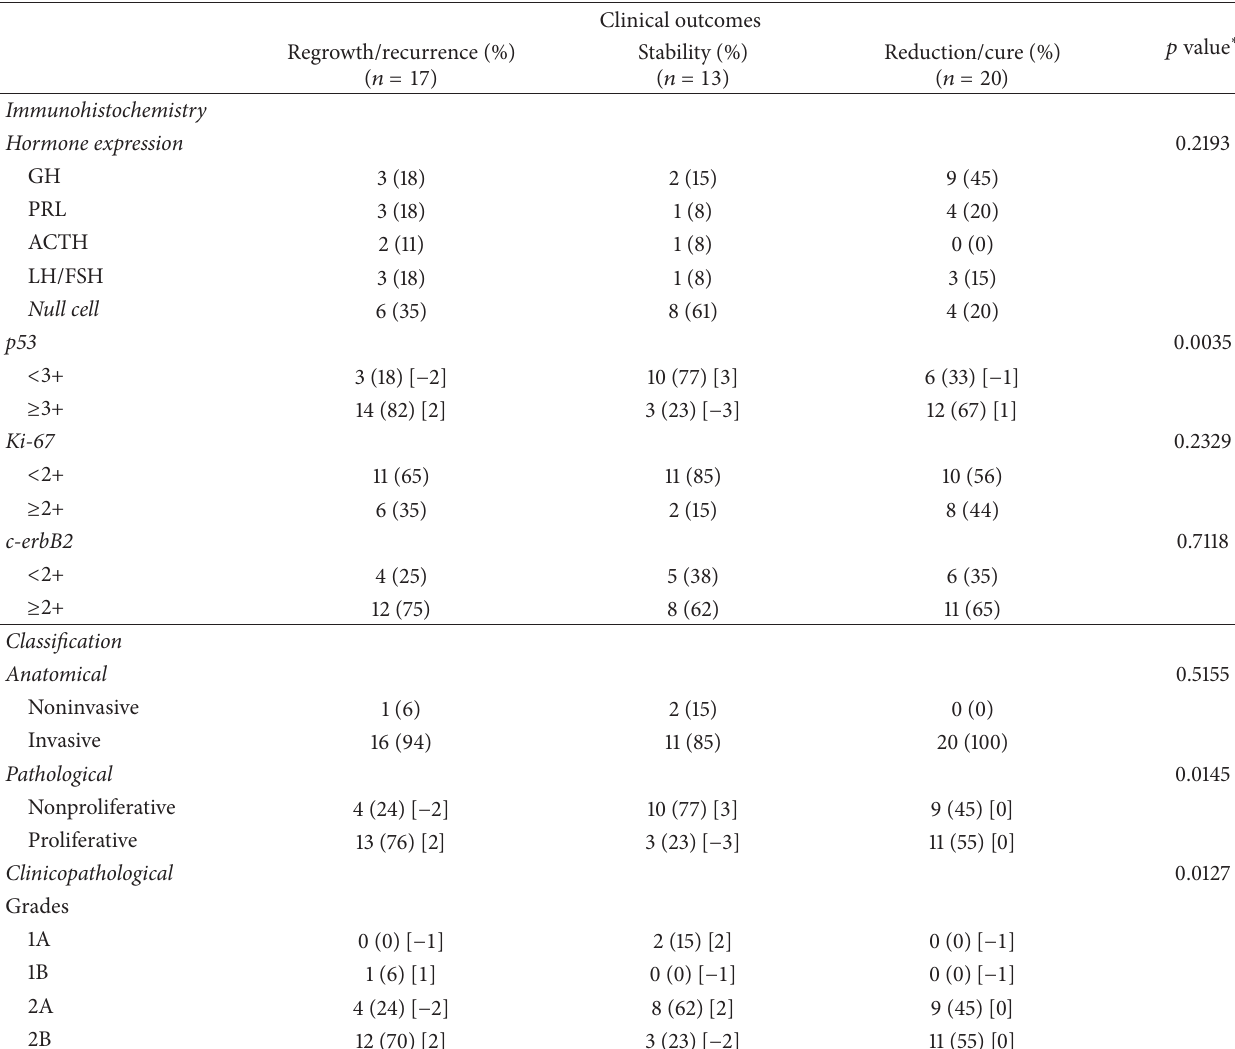
Table 7: Immunohistochemical profile, classification, and tumor evolution classes. Clinical